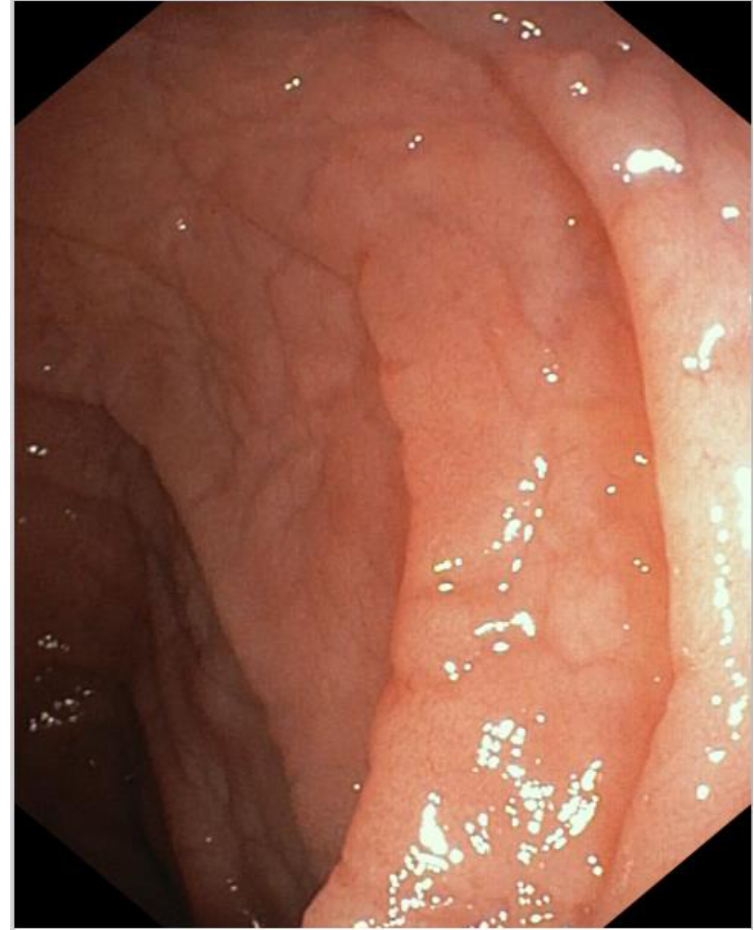
Figure 2. Gastroscopy in patients with cSLE and CD